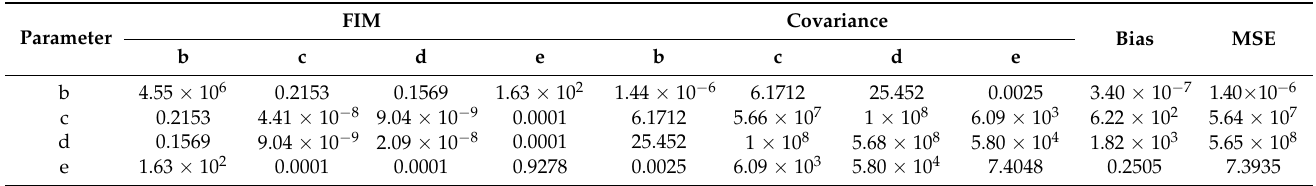
Table 5. Asymptotic approximations of the parameter accuracy metrics of non-uniform sampling.